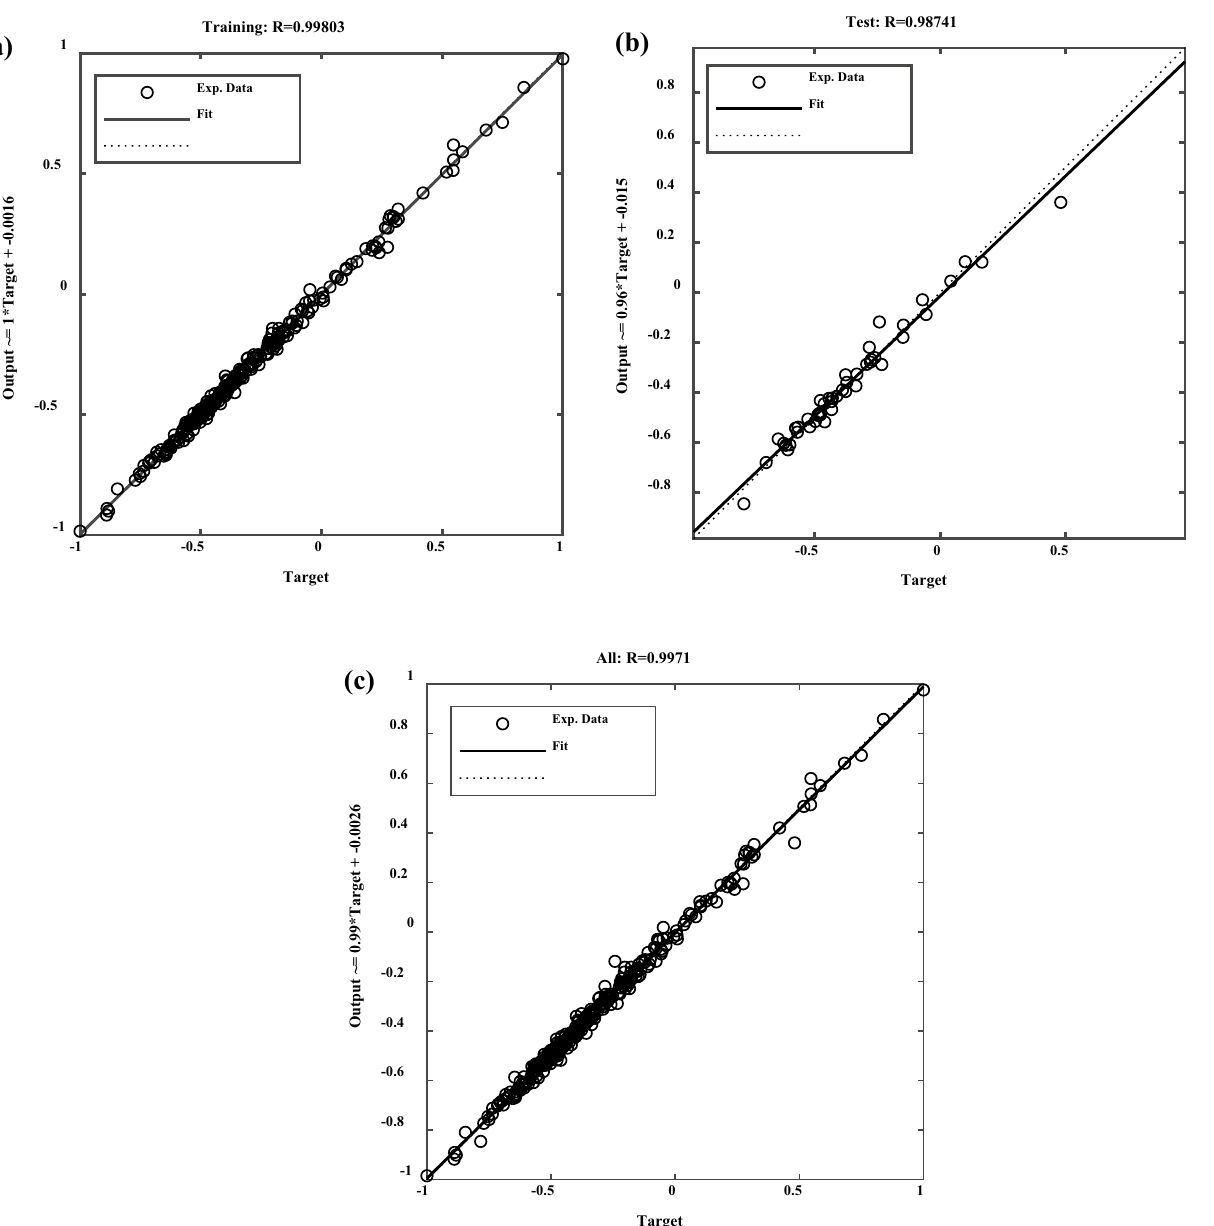
Figure 8. MLP model regression plots prediction ( a ) during training; ( b ) during the test, and ( c ) all the